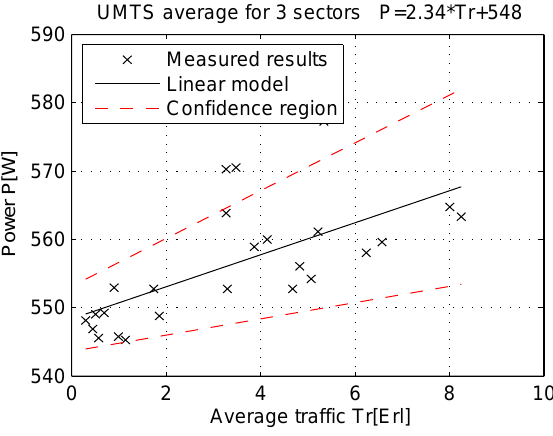
Figure 30. Power consumption model for UMTS BS rack (Sunday, 17/07).